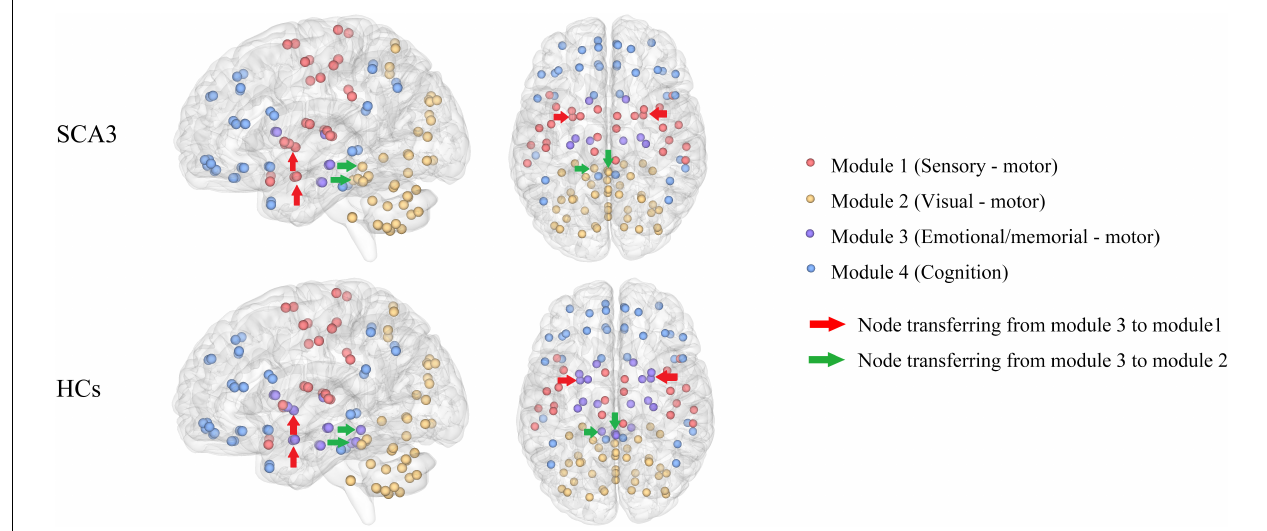
FIGURE 2 | Brain network modularity in patients with SCA3 and HCs. Nodes of the same color are in the same module. Different colors represent different modules. The red arrows indicate the nodes transferred from emotional / memorial—motor into sensory—motor modularity in SCA3 compared to HCs, including the bilateral amygdala and bilateral putamen. Green arrows indicate the nodes transferred from emotional / memorial—motor into visual—motor modularity in SCA3 compared to HCs, including bilateral cerebellar lobules III and vermis I, II, III. HC, healthy controls; SCA3, spinocerebellar ataxia 3.